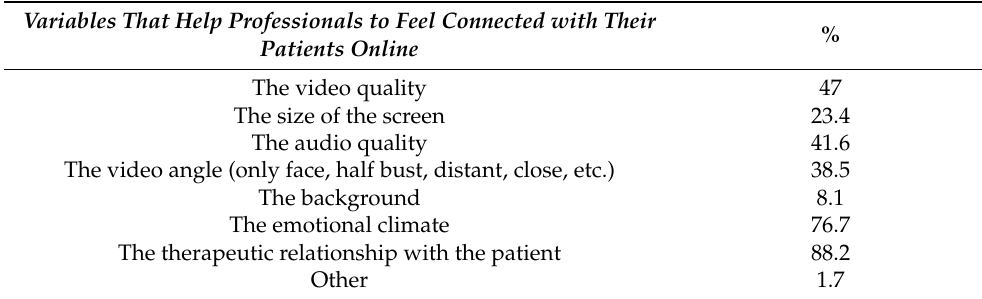
Table 8. Variables that help professionals to feel connected with their patients online. Variables That Help Professionals to Feel Connected with Their % Patients Online The video quality 47 The size of the screen 23.4 The audio quality 41.6 The video angle (only face, half bust, distant, close, etc.) 38.5 The background 8.1 The emotional climate 76.7 The therapeutic relationship with the patient 88.2 Other